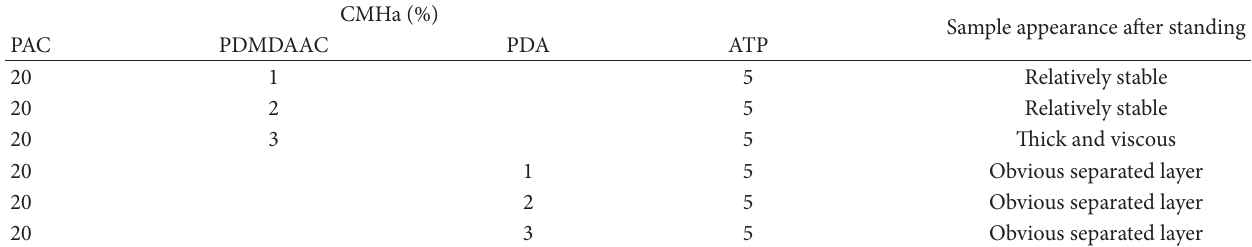
Table 2: The influence of different kinds of cationic polymers on the stability of CMHa.